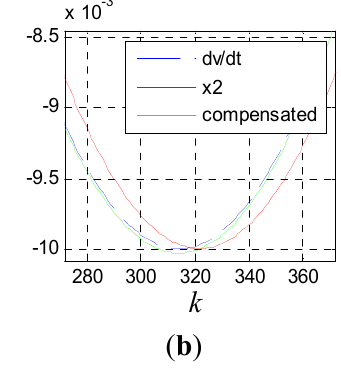
( k ); ( b ) partial enlarged drawing of 2